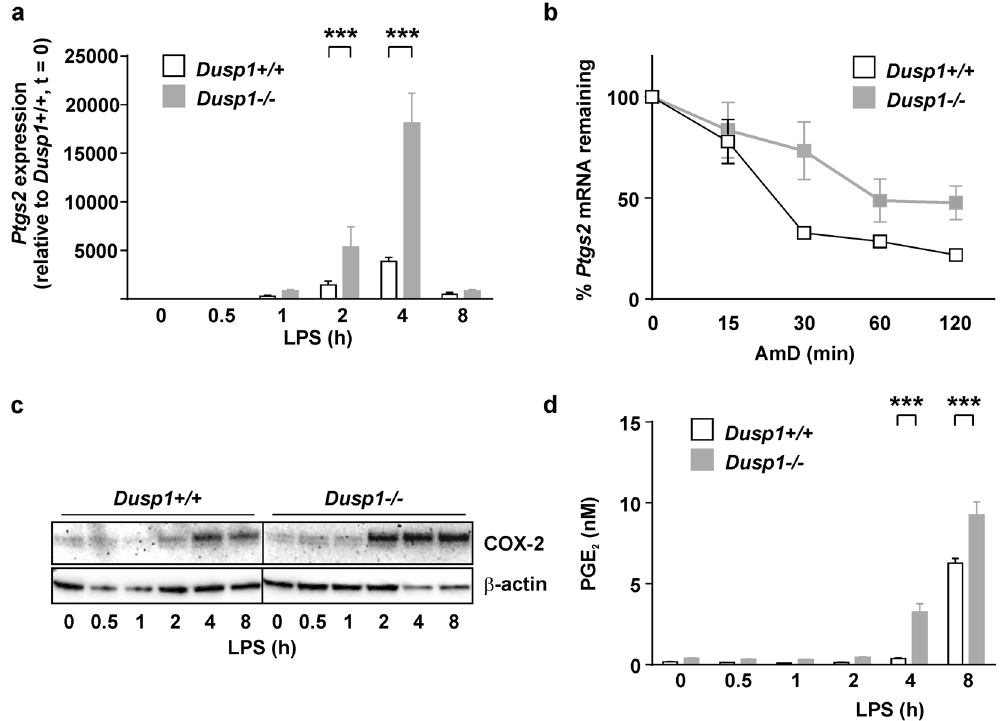
Figure 2. DUSP1 negatively regulates Ptgs2 gene expression at the post-transcriptional level. ( a ) Dusp1 + / + and Dusp1 − / − BMMs were stimulated with 10 ng/ml LPS for the times indicated and Ptgs2 mRNA was measured by qPCR. The graph represents mean ± SEM of three independent BMM cultures of each genotype. *** p < 0.005; Holm-Sidak method for multiple comparison. ( b ) Dusp1 + / + and Dusp1 − / − BMMs were stimulated with LPS for 4 h then actinomycin D was added and Ptgs2 mRNA measured by qPCR at the intervals indicated. The graph shows mean ± SEM of three independent BMM cultures of each genotype. ( c ) Dusp1 + / + and Dusp1 − / − BMMs were stimulated with LPS for the times indicated and COX-2 protein was detected by western blotting. Representative of three similar experiments. ( d ) Dusp1 + / + and Dusp1 − / − BMMs were stimulated with LPS for the times indicated and PGE 2 in the tissue culture supernatant was measured by ELISA. The graph represents mean ± SEM of three independent BMM cultures of each genotype. *** p < 0.005; Holm- Sidak method for multiple